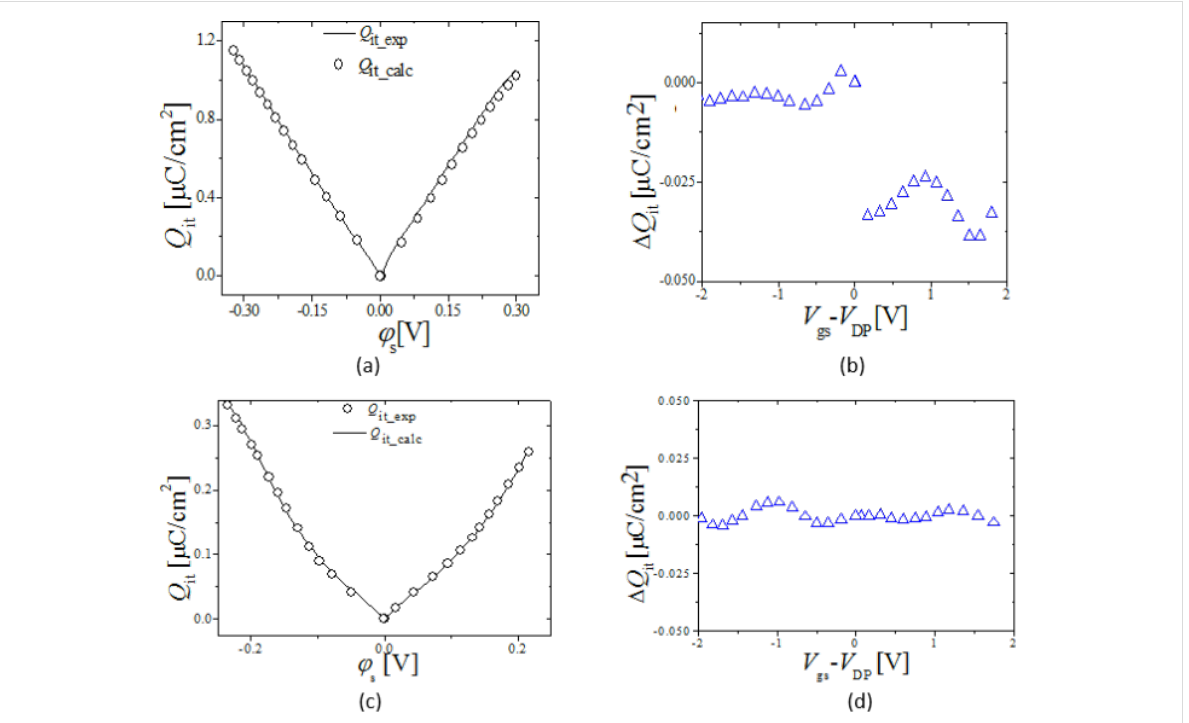
Figure 5: (a) and (c) Q it for Device 1 and 2 respectively, symbols: Q it_exp from Equation 7 as a function of φ s_exp , line: Q it_calc calculated from Equa- tion 9–11 as a function of φ s_calc . Figure 5b and 5d show the difference in Q it_calc and Q it_exp as a function of V gs for Device 1 and 2 respectively.